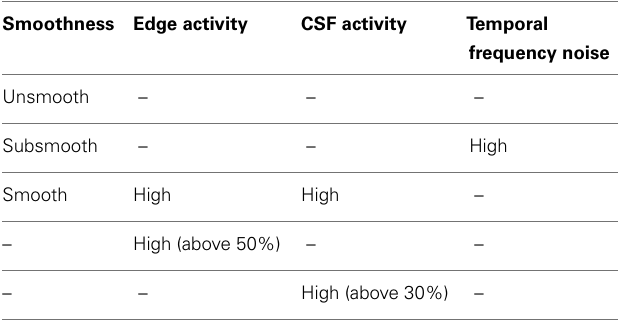
Table 1 |The conditions used to automatically identify ICs dominated by artifact.